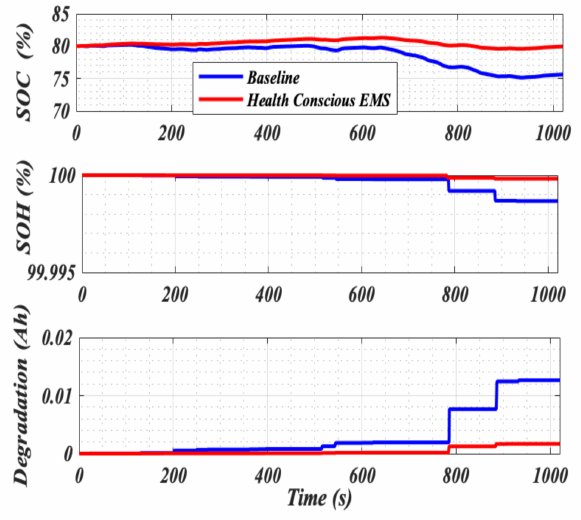
Figure 9. Battery SOC, SOH, and degradation for the NEDC cycle.